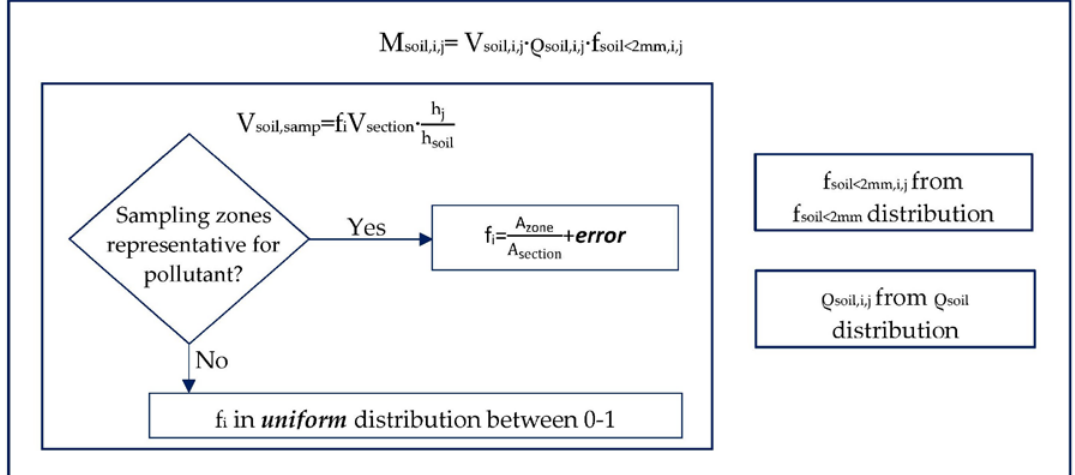
Figure 6. Method for selecting soil mass associated with each sample and each pollutant